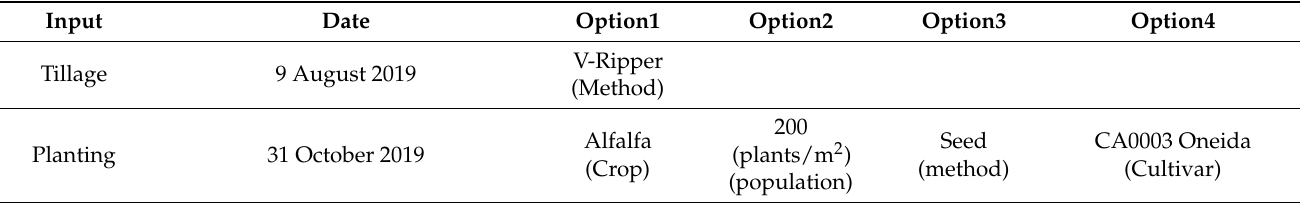
Table 7. Management practices schedule for simulation (Simulation Date: 5 June